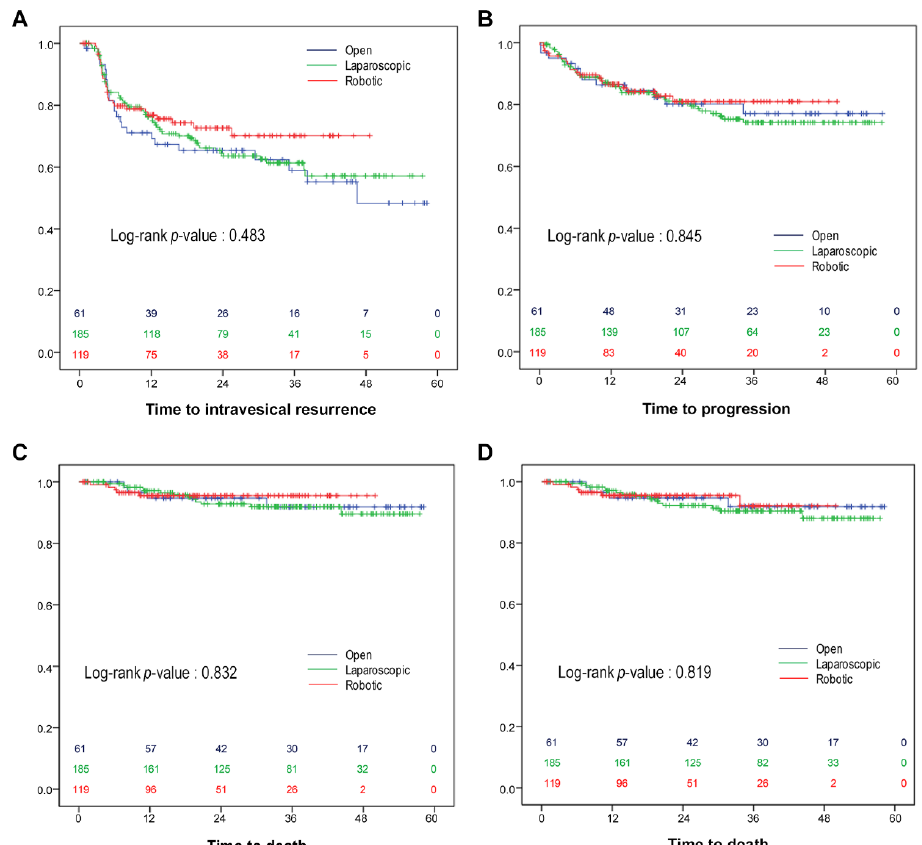
Figure 1. Kaplan – Meier survival analyses estimated intravesical recurrence-free survival ( A ), progression-free survival ( B ), cancer-specific survival ( C ), and overall survival ( D ), stratified by the surgical approach. Red, robotic; green, laparoscopic; blue, open radical nephroureterectomy. Table 3. Multivariate analysis with Cox-proportional hazards regression to predict progression-free survival, cancer-specific survival, and overall survival.